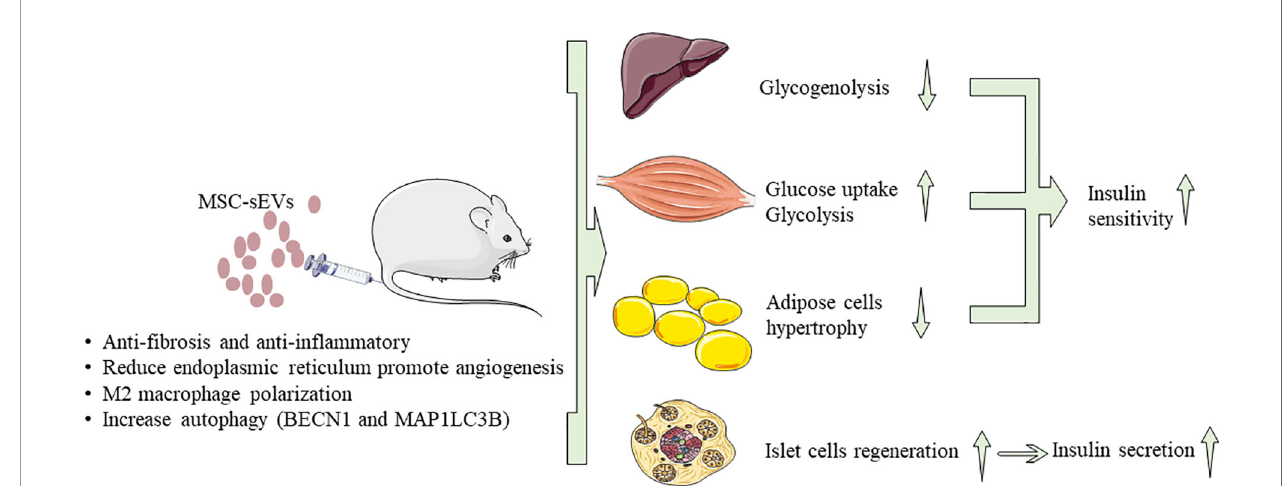
FIGURE 2 | The approach of MSC-sEVs to treat diabetes. MSC-sEVs down regulate blood glucose through reverse insulin resistance in insulin target tissues (liver, muscle, adipose tissue) and relieve islet b cells